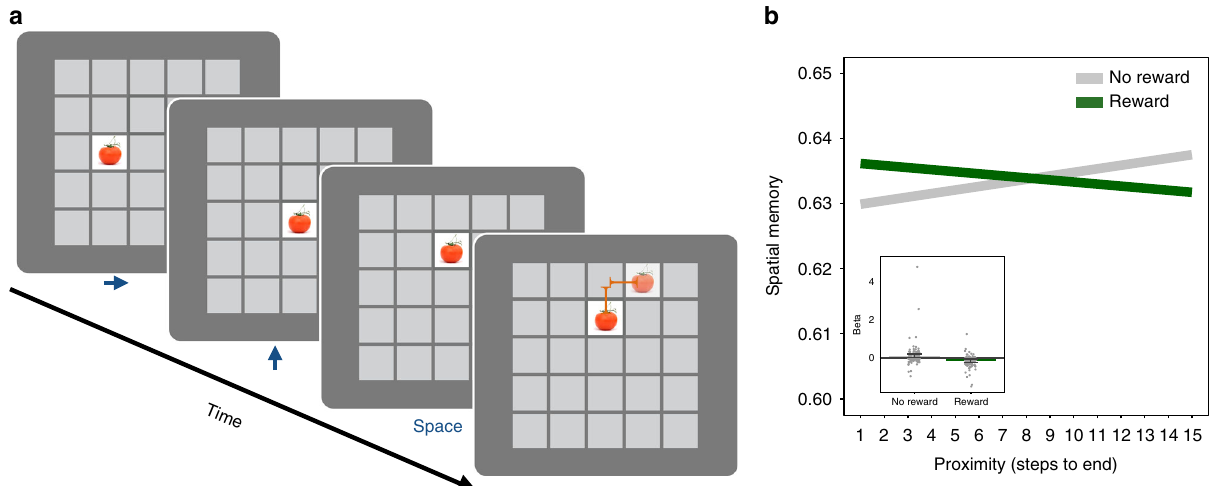
Fig. 5 Rewards retroactively modulate spatial location memory. a Schematic of surprise spatial location memory test. An old object was randomly placed in a maze square, and participants were instructed to move the object back to the square where they originally saw the object by using arrow keys to move through the maze and then pressing the space bar to indicate the chosen location (self-paced). b Reward retroactively modulated spatial memory for sequentially proximal objects such that spatial location memory decreased as proximity to the end of the maze increased for the no (or low) reward mazes (Experiments 1 – 4 combined, 24-hour conditions only, n = 146). The inset depicts the beta coef fi cients for the reward and no-reward conditions. The error bars represent the standard error of the reward × proximity interaction and the dot plot overlay shows the reward and no-reward betas across